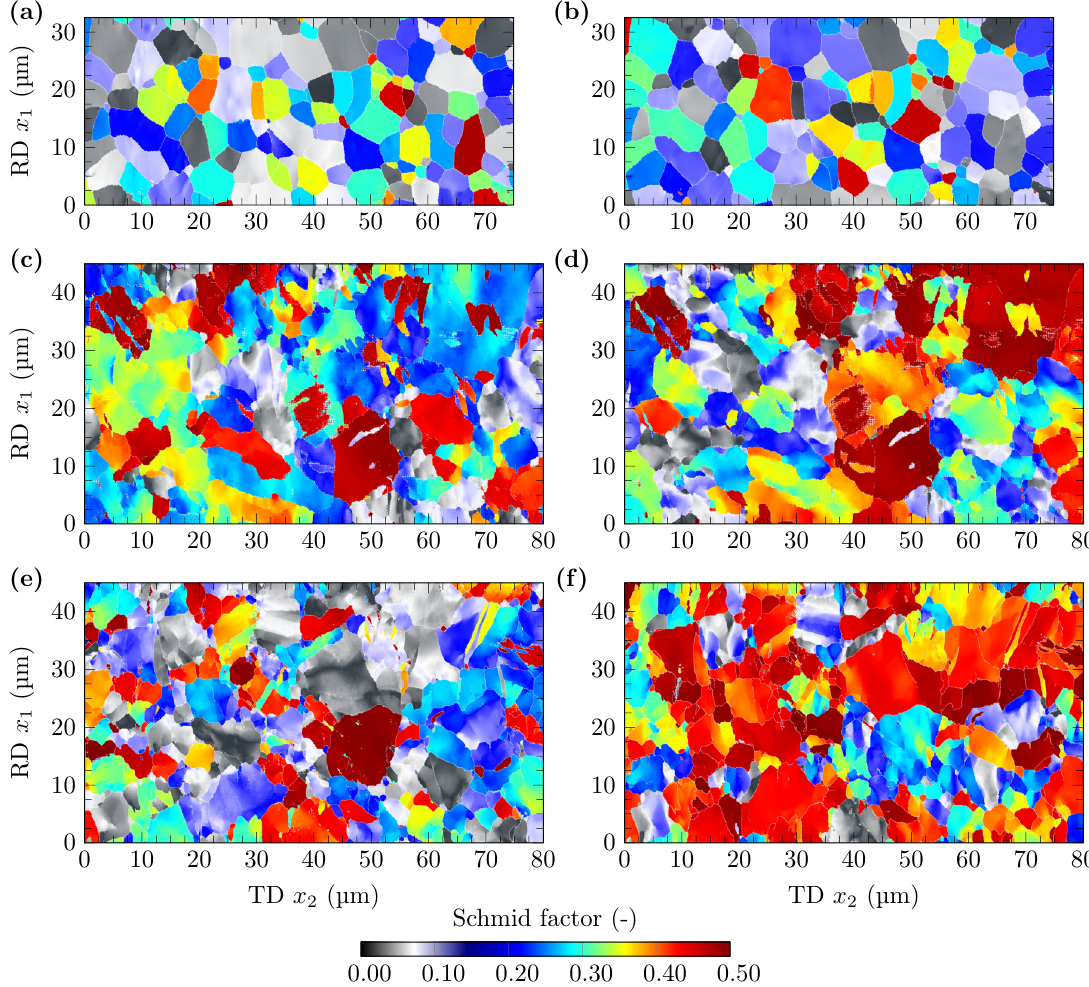
Figure 7. Schmid factor maps for basal slip ( a ) from the as-received material with respect to a possible load in RD and ( b ) TD; ( c ) of the hot-bent material from the tension layer with respect to a possible load in RD and ( d ) TD; ( e ) of the hot-bent material from the compression layer with respect to a possible load in RD and ( f ) TD. Figure 7c–f show the Schmid factor maps for basal slip for a possible load in RD and TD of the hot-bent material from the tension and compression layer,